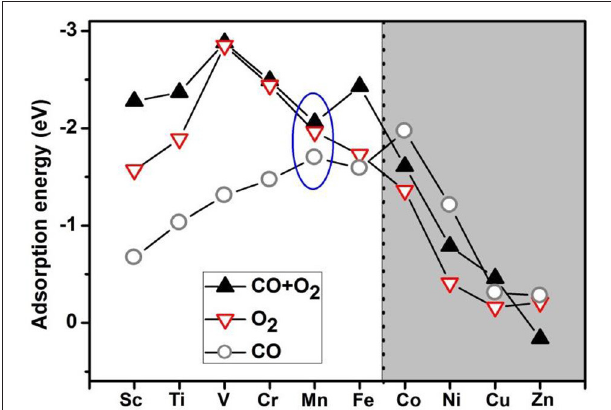
FIGURE 1 | The adsorption energies of O 2 and CO as well as the co-adsorption energy of O 2 and CO on TM-DG, where the light and dark areas indicate the preferential adsorption of O 2 and CO molecules,